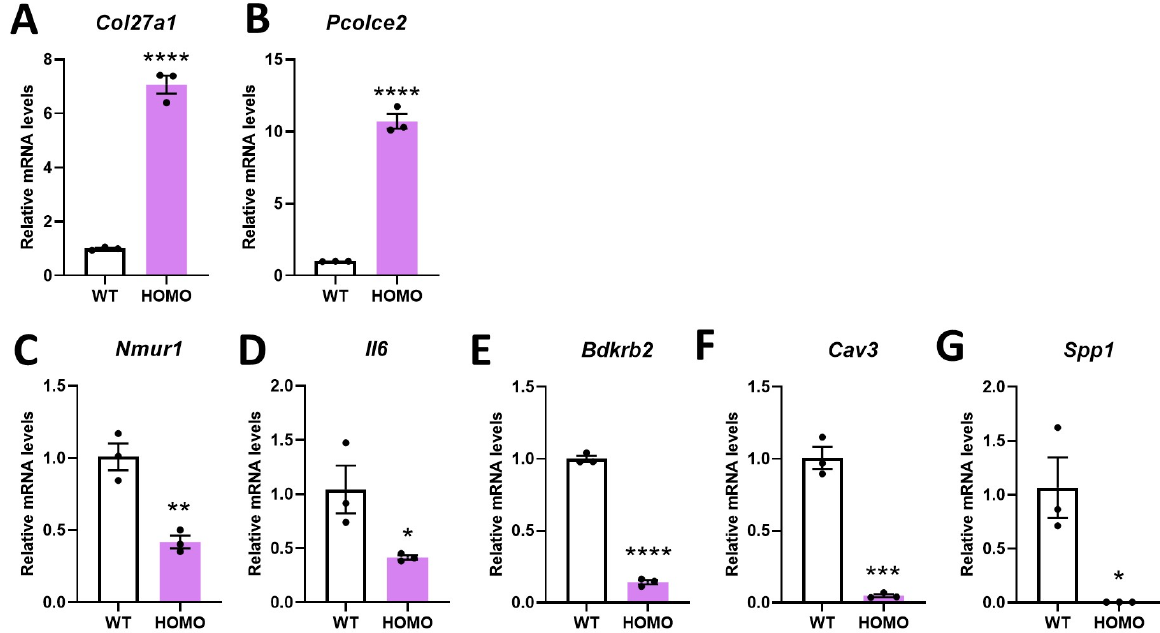
Figure 3. Impact of hIGFBP5 on the mRNA levels of genes of interest in pFBs. Expression levels of genes of interest were quantified by qRT-PCR. ( A ) Col27a1 . ( B ) Pcolc2 . ( C ) Nmur1 . ( D ) Il6 . ( E ) Bdkrb2 . ( F ) Cav3 . ( G ) Spp1 . n = 3 per group. The housekeeping gene used to normalize the data was B2m . * p < 0.05. ** p < 0.01. *** p < 0.001. **** p < 0.0001. WT: wild type female mice, HOMO: hIGFBP5 homozygous female mice. Table 3. Summary of experiments. Selected GOIs that were DEGs in hIGFBP5 pFBs of female HOMO mice were further analyzed by qRT-PCR and immunoblotting (cell lysates and conditioned media abbreviated cond. media). Down (down- regulated, blue) and Up (upregulated, red) indicates the direction of regulation in hIGFBP5 pFBs of HOMO female mice as compared to pFBs of WT female mice. NA: not analyzed.